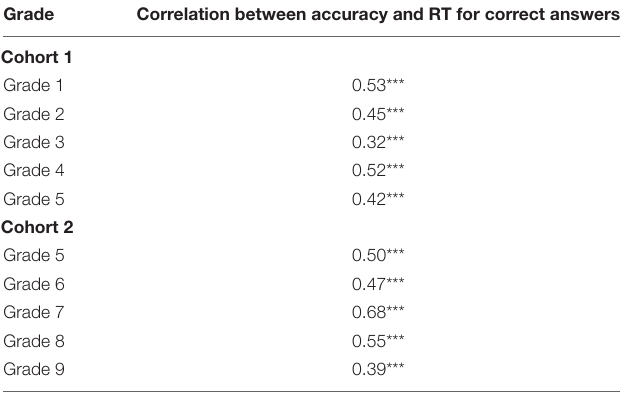
TABLE 2 | Correlations between accuracy and mean RT for correct answers.